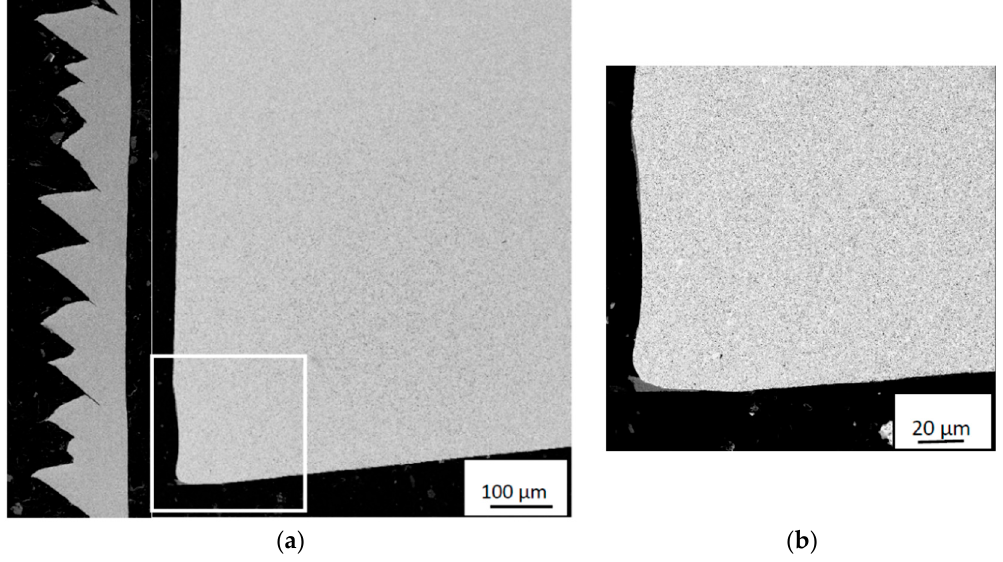
Figure 1. Cross-sections of Ti6Al4V chip and cemented carbide insert (to scale) illustrating the chip thickness and morphology with respect to the size of the flank and the crater on the insert rake face. ( a ) At lower and ( b ) at higher magnification. The pronounced segmented nature of the chip generates cyclic stresses which promote surface fatigue of the cutting